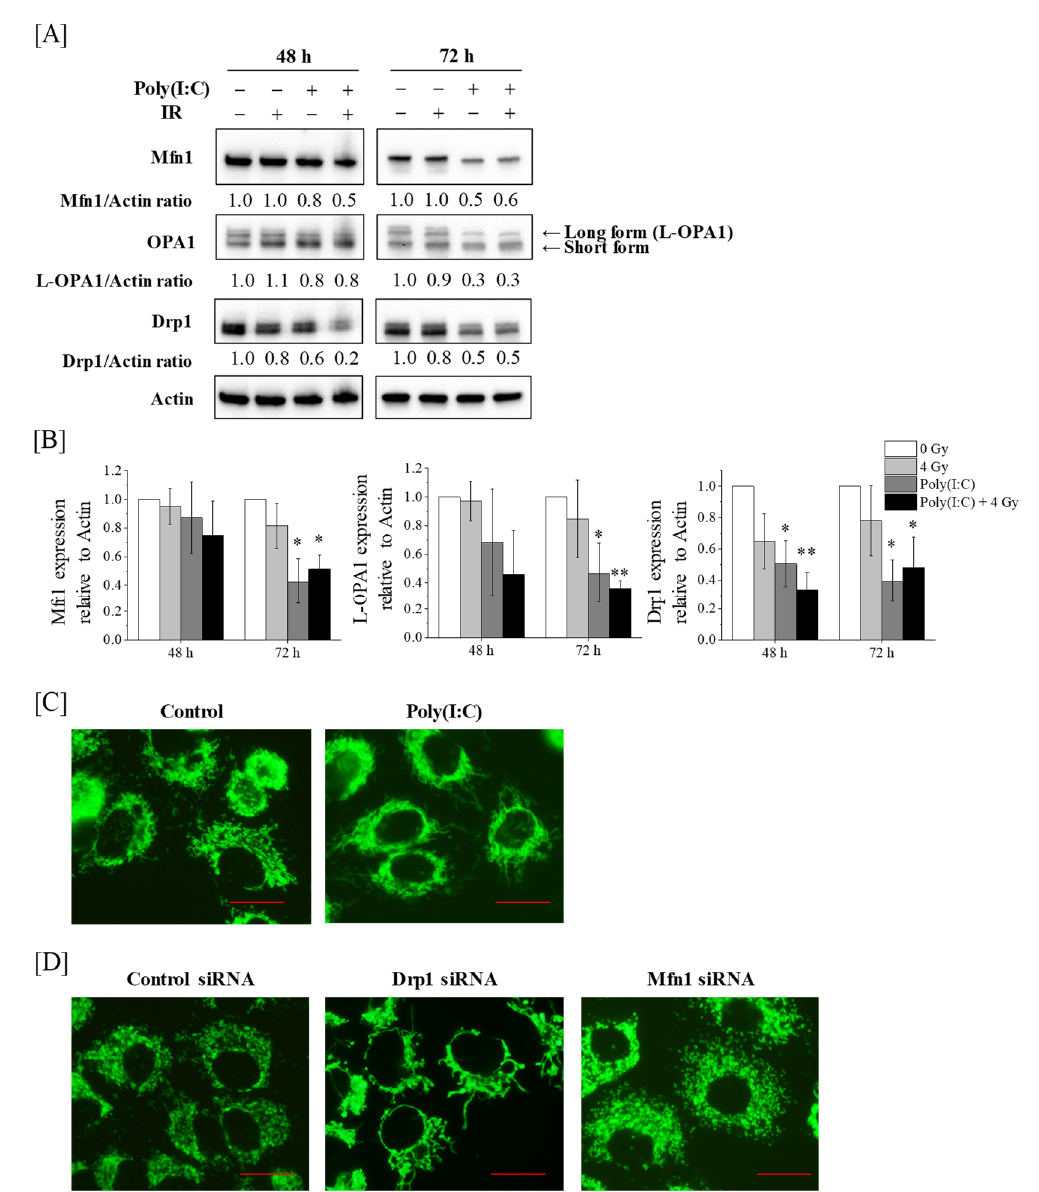
Figure 1. Effect of Poly(I:C)-HMW/LyoVec™ (Poly(I:C)) and/or ionizing radiation (IR) on mitochondrial dynamics in A549 cells. ( A , B ) A549 cells were incubated with Poly(I:C). After incubation for 1 h, the cells were irradiated with 4 Gy. After culturing for 48 or 72 h, the cells were harvested for western blotting. ( A ) Representative images of immunoblots are shown. Actin was used as a loading control. ( B ) The relative values of Mfn1/actin, L-OPA1/actin and Drp1/actin ratio are presented as mean ± SD of three independent experiments. For the Drp1 proteins, both bands were quantified together. One sample t- test was performed using the GraphPad QuickCalcs. * p < 0.05, ** p < 0.01 versus control. ( C ) A549 cells cultured for 72 h in the presence of Poly(I:C) were harvested for mitochondrial morphology analysis using the MitoTracker TM Green FM. ( D ) A549 cells transfected with control, Drp1, or Mfn1 siRNA were cultured for 72 h and harvested for mitochondrial morphology analysis. Scale bar = 20 μ m.